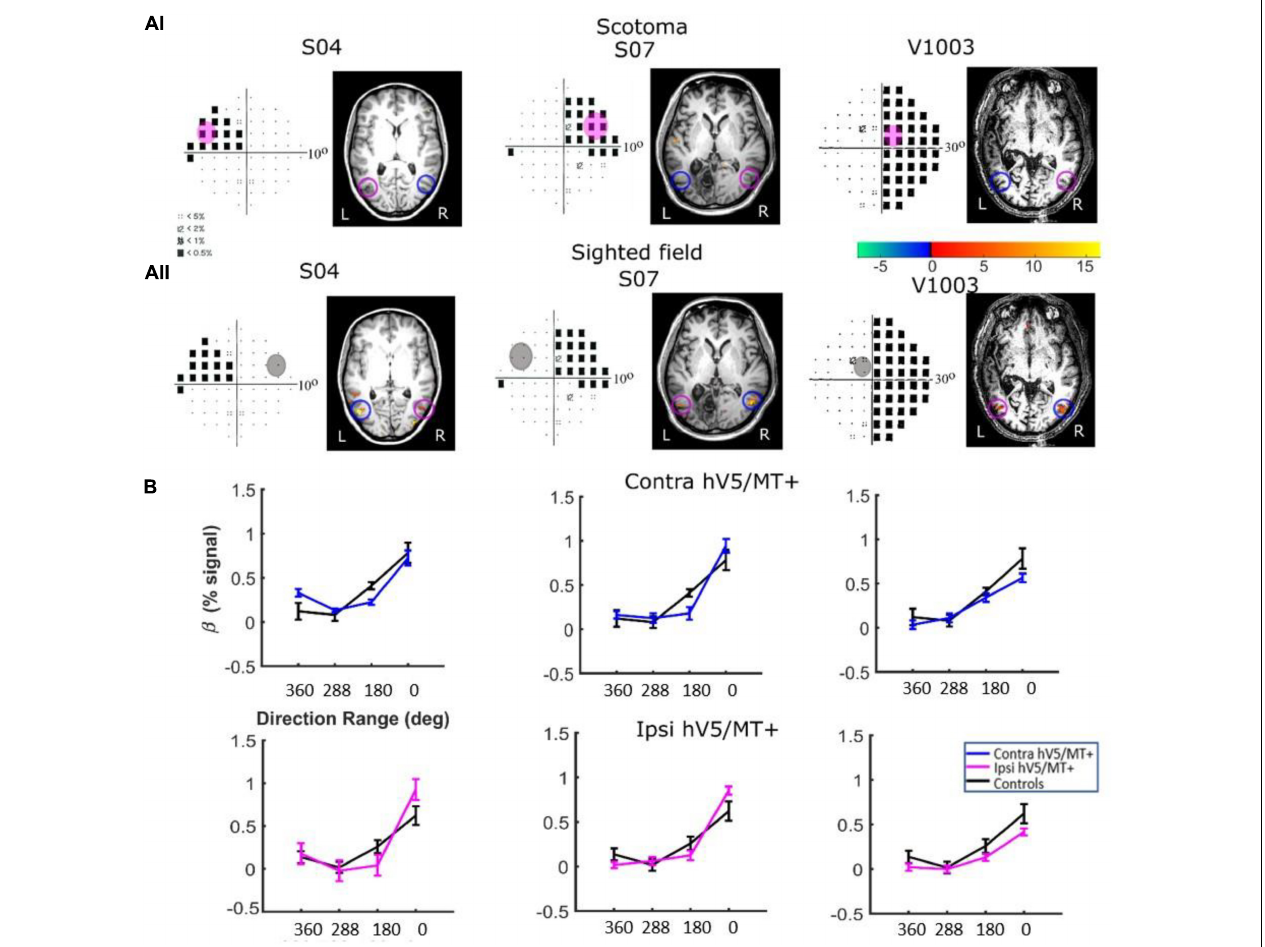
FIGURE 8 | hV5/MT+ responses to motion coherence in three patients during the passive task. (Ai) Visual field deficits for each patient based on perimetry and activation maps when the stimulus was presented within the blind visual field (magenta disk). We found no significant activity in either the contralesional (blue circle) or ipsilesional (magenta circle) hV5/MT+ when the stimulus was presented within the patients’ scotoma and the patients were performing a passive fixation task. (Aii) Activation maps when the stimulus was presented within the sighted visual field (gray disk). We found significant activity for both the contralesional (blue circle) and ipsilesional (magenta circle) hV5/MT+ when the stimulus was presented in the sighted field of the patients. (B) Mean GLM β weights of hV5/MT+ across patients as a function of coherence level when the stimulus was presented within their sighted visual field compared with control subjects (black). Responses in both the contralesional (blue) and ipsilesional (magenta) hV5/MT+ were similar to control